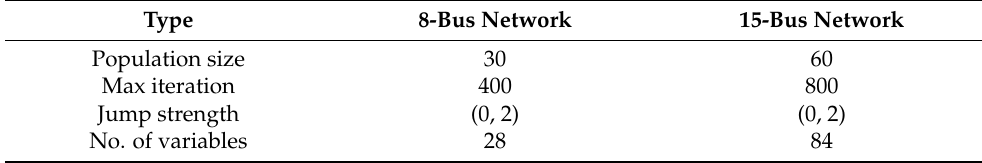
Table 2. Parameters of the algorithm.